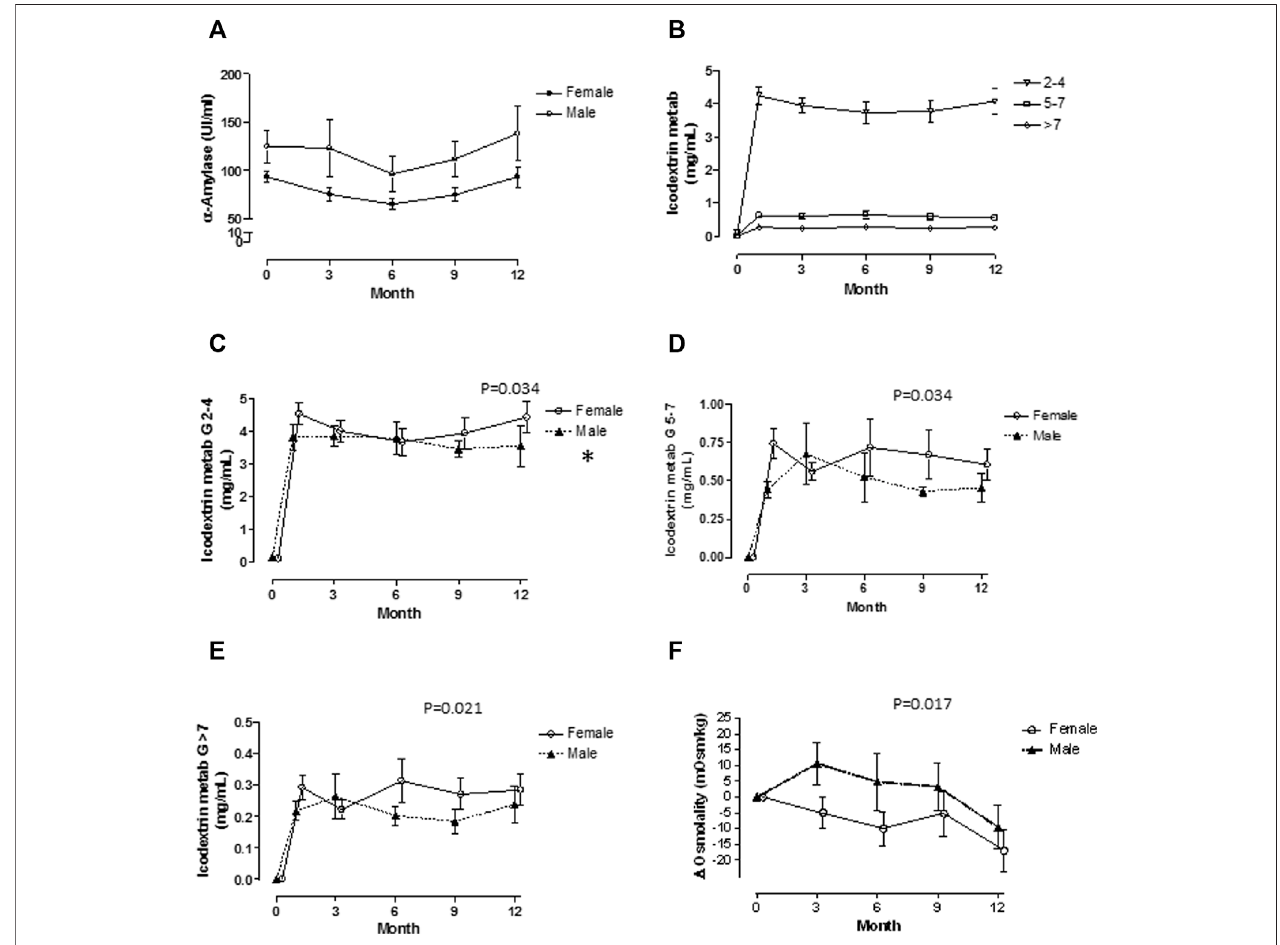
FIGURE1| Biochemicalvariablesareshownbysex. α -Amylaseactivity (A) wassigni fi cantlylowerinfemales.PlasmalevelsofIcodextrinmetaboliteswereinversely relatedwithits molecularsize (B) .PlasmalevelsofG2-G4 werenotdifferentbysex (C) , but signi fi cantincrements inG5-G7 (D) and > G7 (E) , werefoundin femalesover males after 6 months of treatment. Plasma osmolality was lower in females (F) .